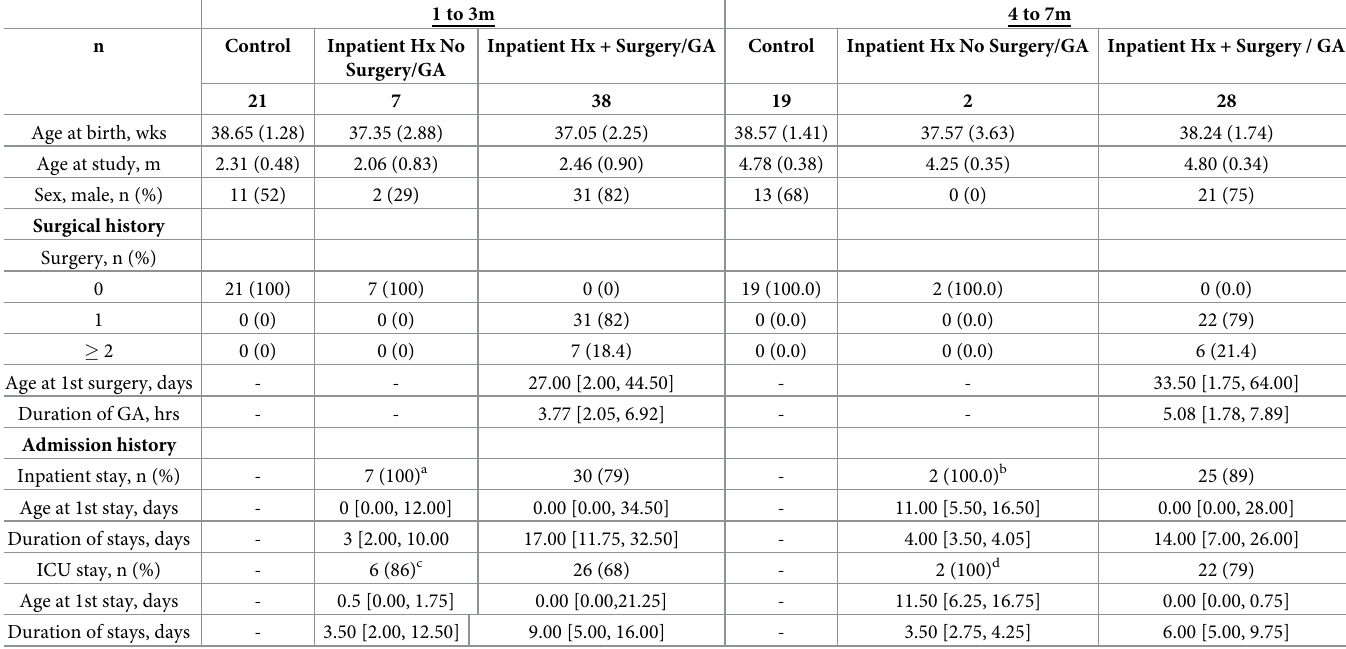
Table 1. Demographics and clinical characteristics of the sample separated by age group and inpatient history at the time of